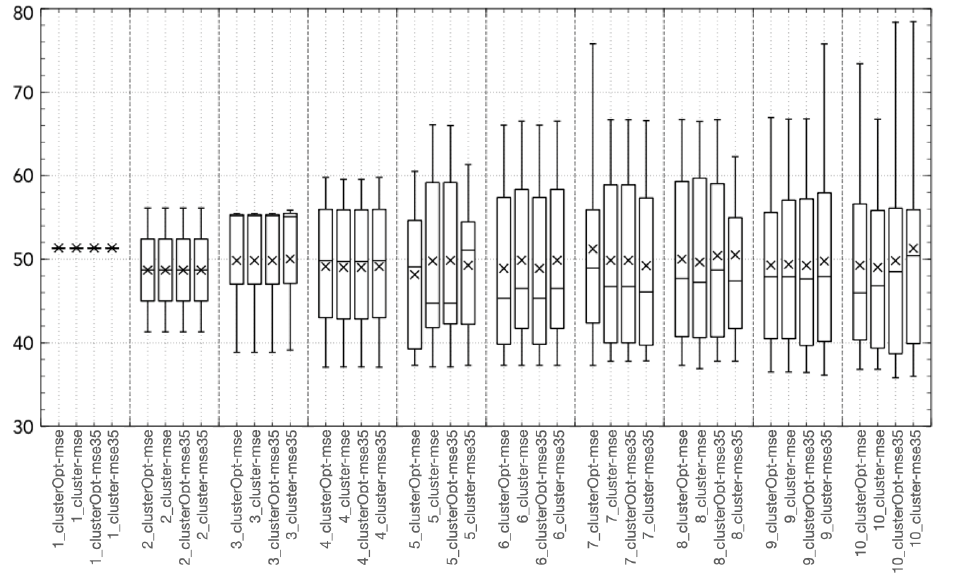
Figure 3. Boxplot of coordinate 1 ( y ( t − 1 ) , NO 2 concentration at time t − 1) of the centroid [ µ g/m 3 ].